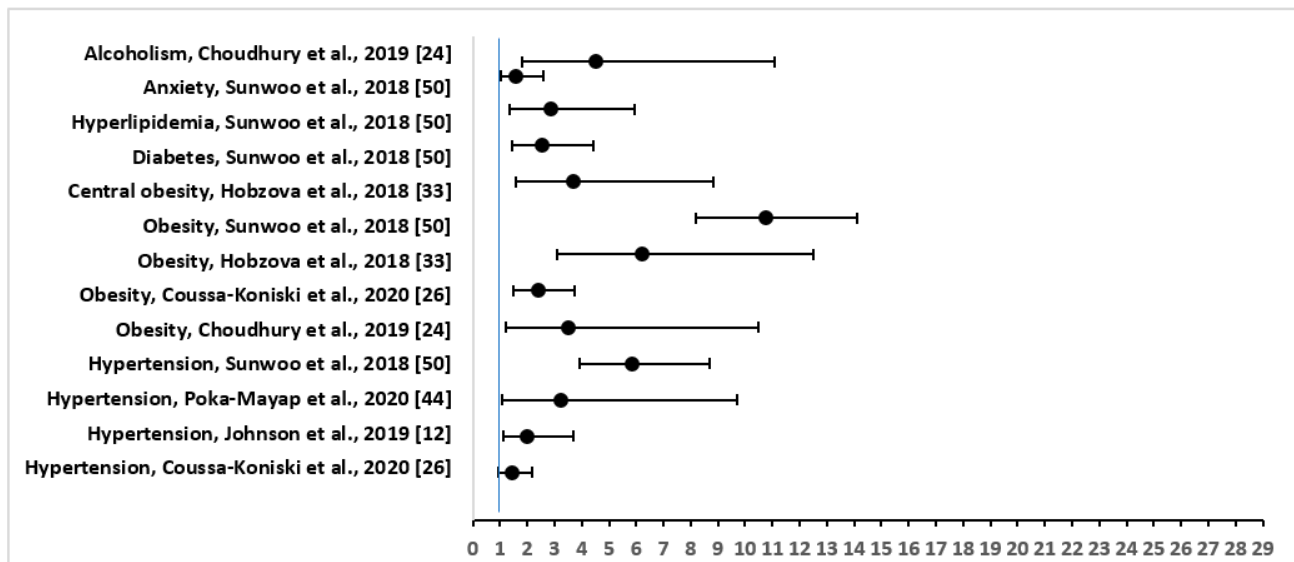
Figure 2. Forest Plot of Odds Ratio with 95% Confidence Intervals for Risk Factors or Comorbidities of Severe Obstructive Sleep Apnea.